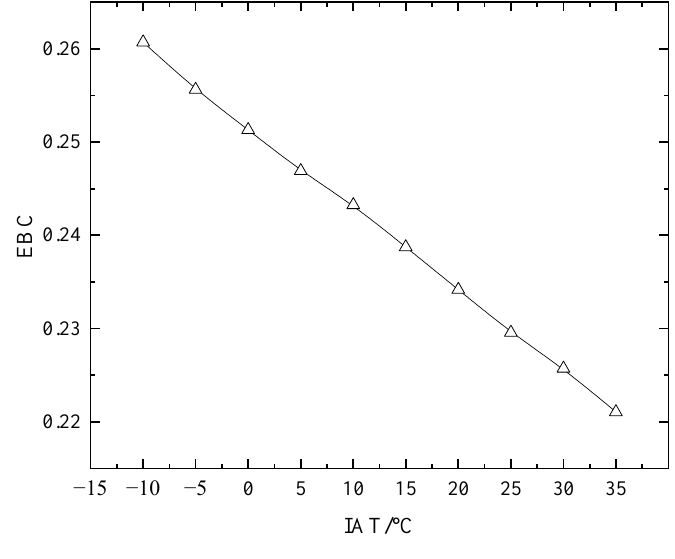
Figure 10. Influence of IAT on EBC.